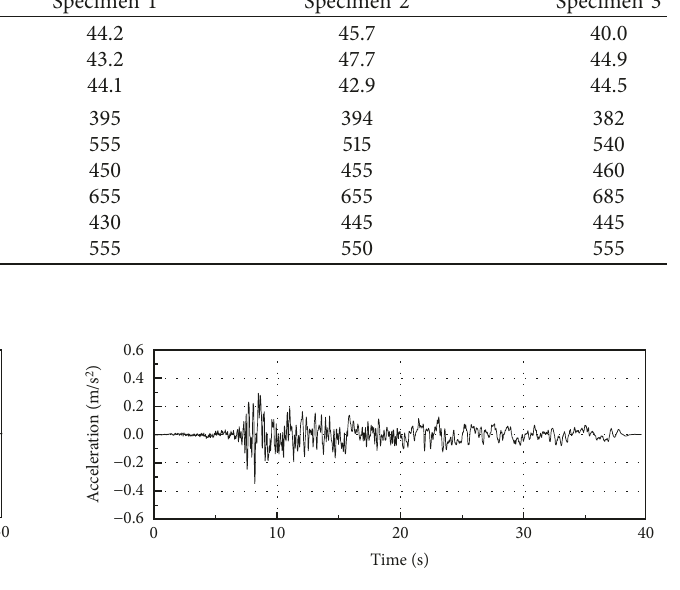
Figure 7: Earthquake acceleration time-history curve of intensity 7 frequently of Imperial Valley (longitudinal input).